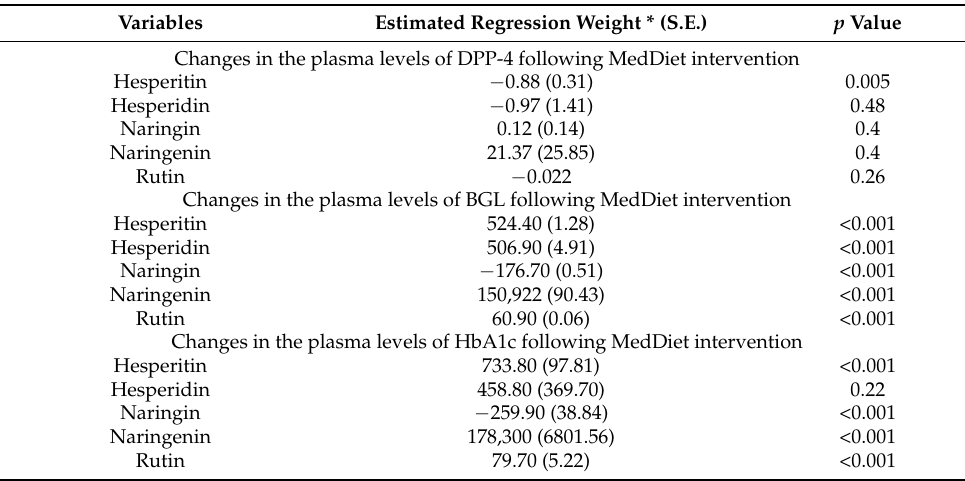
Table 3. Predicted correlations between changes in the plasma levels of DPP-4, BGL and HBA1c and changes in plasma levels of citrus bioflavonoids following MedDiet